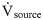
Illustration of bench simulation results: Polygraph nasal airflow versus bench airflow.(a) and (b): example of a breathing profile with obstructive apnea events marked in orange shade. The polygraph nasal airflow (V˙source) and bench simulation airflow (V˙bench) are respectively showed in (a) and (b) with blue curves. The red curve in (b) represents the estimated non-obstructed nasal airflow (V˙cc), issuing from a central ventilation command. (c) and (d): example of a breathing profile without disordered breathing events. The V˙source and V˙bench are respectively showed in (c) and (d) with blue curves. The magenta points in all graphs represent the breath onsets.